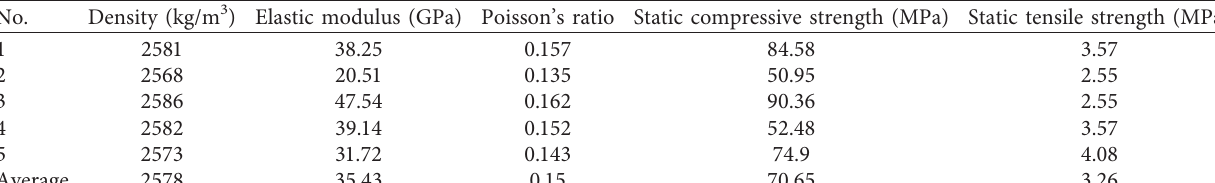
Table 1: The static mechanical parameters of granite.